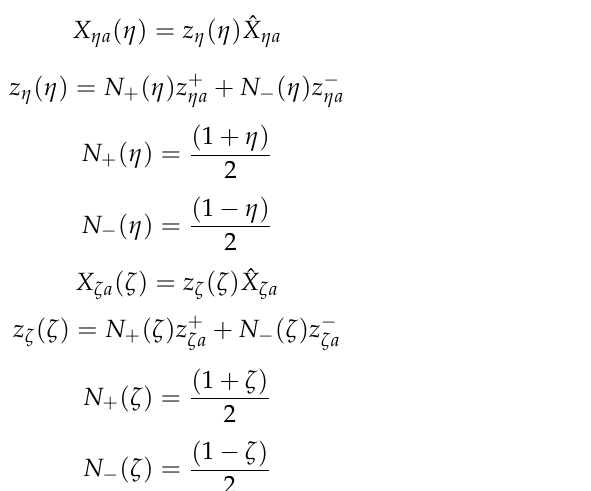
where 𝑥̅ denotes a position vector to a point on the reference axis of the beam, and 𝑋 𝜁 and 𝑋 𝑥̅ on the axis that define the beam element directions 𝜂 are positions vectors at point through that point.